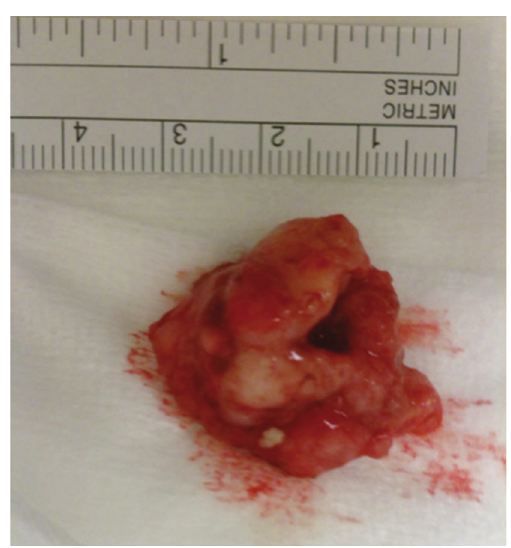
Figure 2: Tumorous tissue causing the bronchial obstruction.